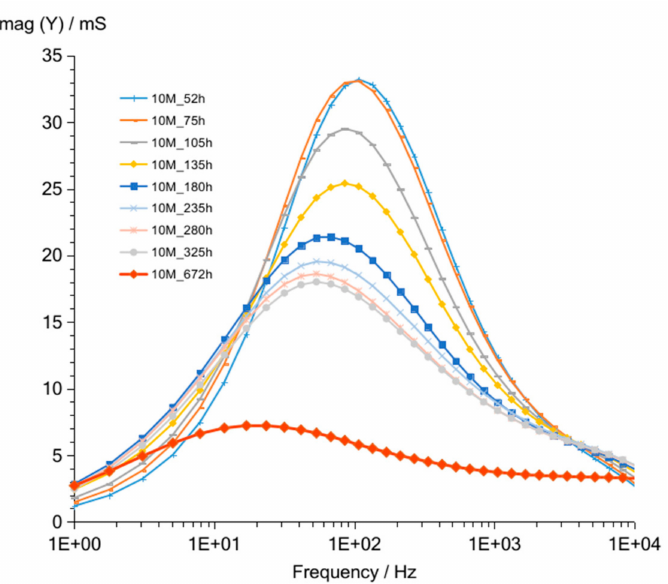
Figure 8. Susceptance of G10M geopolymer concrete taken after 52 to 672 h from starting